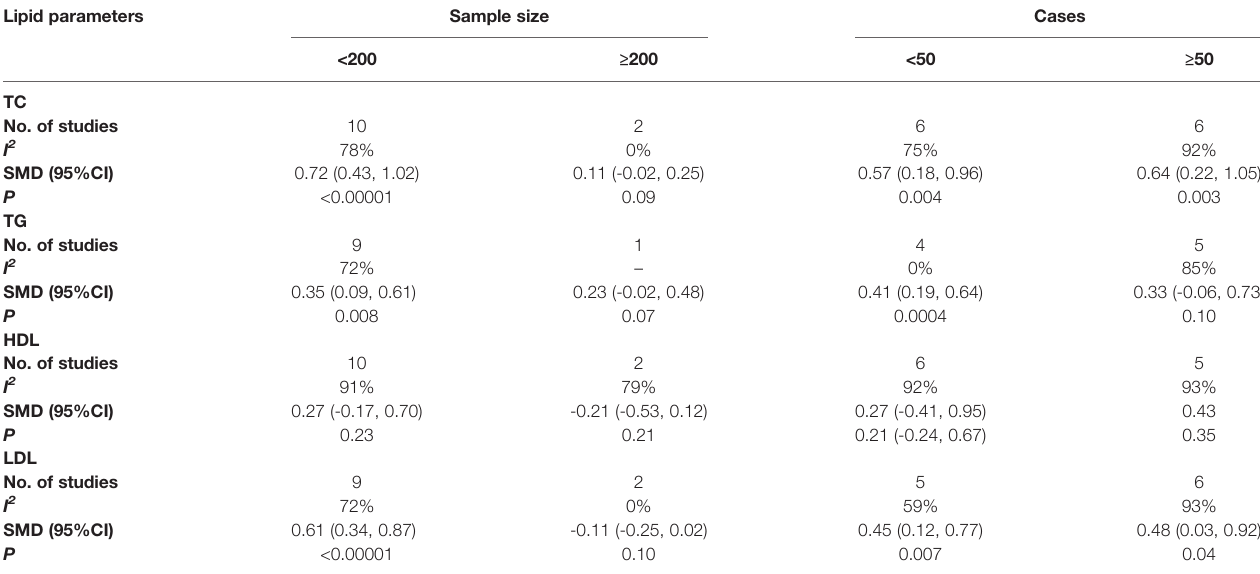
TABLE 3 | Subgroup analysis to investigate the relationship between sample size, number of cases and TC, TG, HDL, LDL. Lipid parameters Sample size